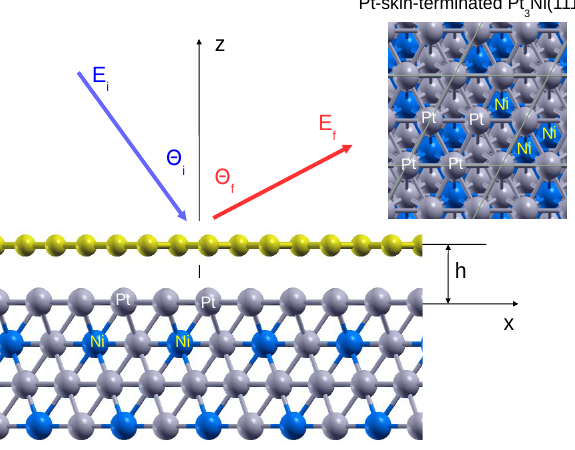
Figure 1. Crystal structure of graphene deposited on the Pt-skin terminated Pt 3